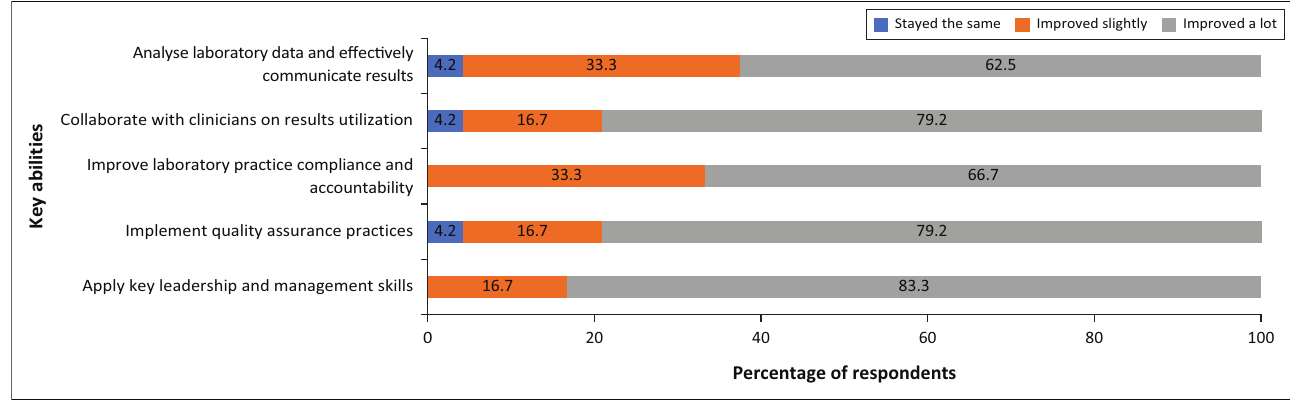
FIGURE 3: Participants’ self-perceived changes in key abilities after laboratory leadership and management programme in Zambia, 2016–2018. A Likert scale-based survey conducted of all programme graduates was conducted in 2018 by an external organisation. Graduates of the programme self-reported key changes in abilities as a result of the programme ( n = 24 respondants) and percentage of each response were calculated and shown